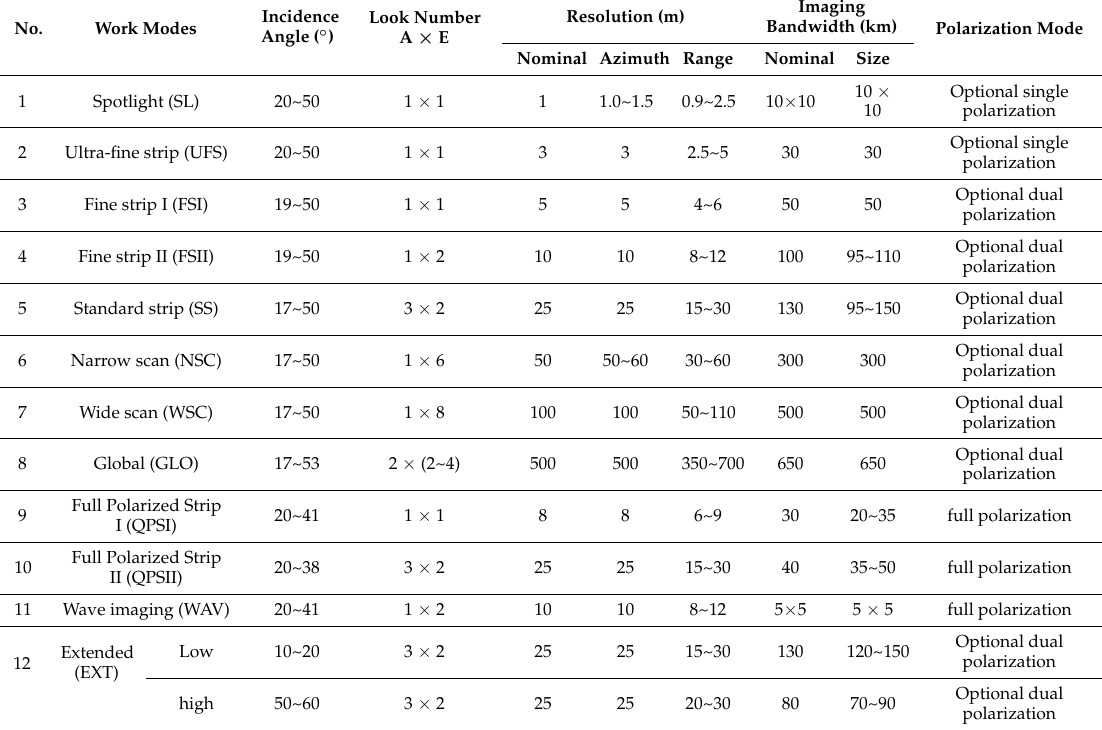
Table 1. Observation patterns of the GaoFen-3 (GF-3)